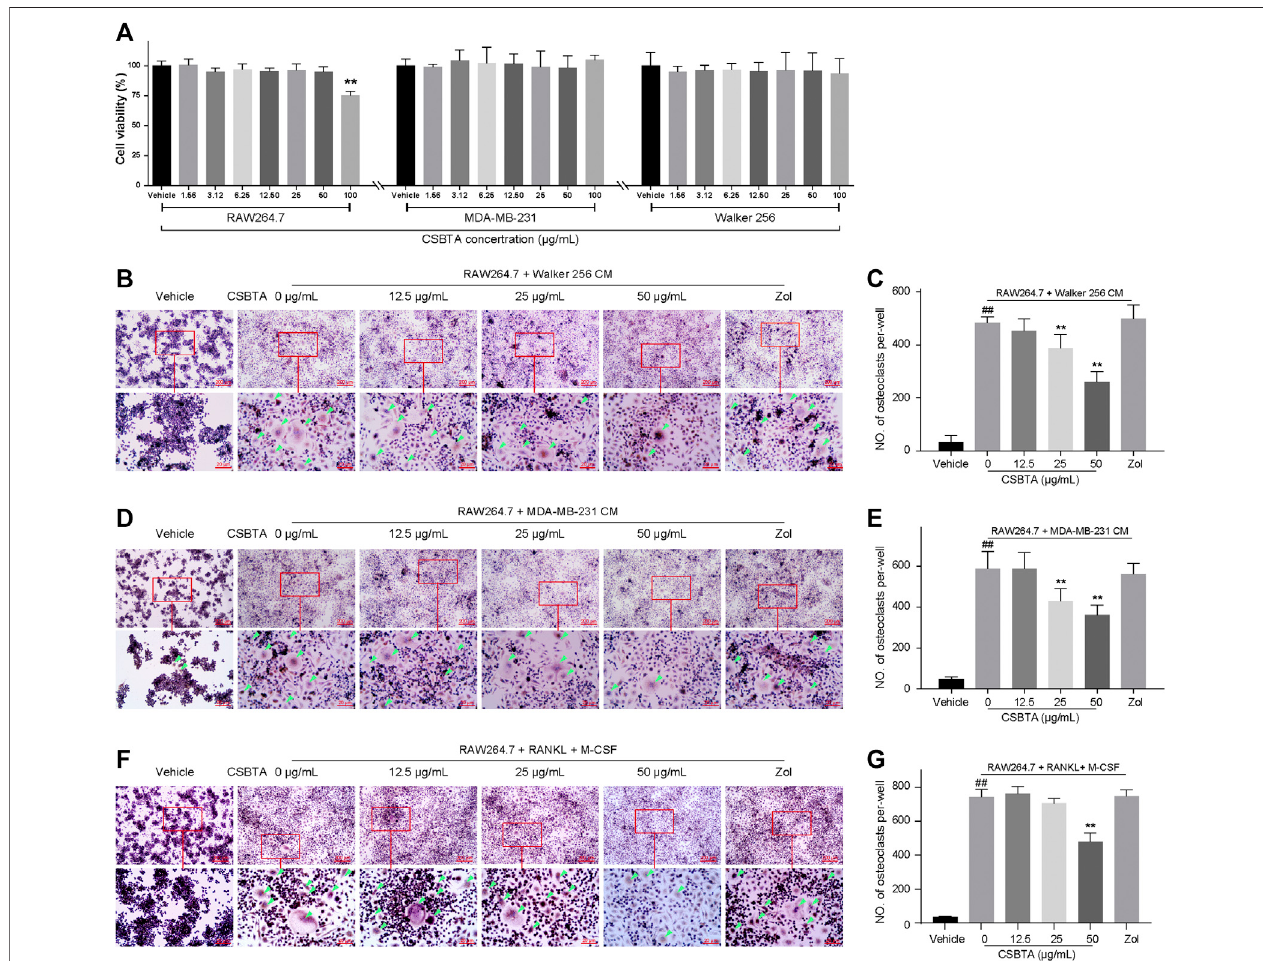
FIGURE 4 | CSBTA inhibited cancer-induced osteoclastogenesis in vitro . (A) Viability of RAW 264.7, MDA-MB-231 and Walker 256 cells after incubation with CSBTAfor 24 h ( n (cid:2) 6). (B) RAW 264.7 cellswere stimulated by Walker 256CM with or without varyingconcentrations ofCSBTA for 4daysfollowed TRAPstaining. (C) The number of TRAP positive cells of the Walker 256 CM induced RAW 264.7 cells per-well. (D) RAW 264.7 cells were stimulated by MDA-MB-231 CM with or without varying concentrations of CSBTA for 5 days followed TRAP staining. (E) The number of TRAP positive cells of the MDA-MB-231 CM induced RAW 264.7 cells per-well. (F) Effect of CSBTA treatment on osteoclast formation in RAW 264.7 (RAW) stimulated by sRANKL (100 ng/ml) and M-CSF (50 ng/ml) for 6 days. (G) The number of TRAP positive cells of the sRANKL (100 ng/ml) and M-CSF (50 ng/ml) induced RAW 264.7 cells per-well. The osteoclasts were marked by green triangles. All experiments were repeated at least three times. Datawas expressed as means ± SD and analyzed by one-way ANOVA. # p < 0.05, ## p < 0.01 vs. the Vehicle group. * p < 0.05, ** p < 0.01 vs. the 0 μ g/ml CSBTA group. Scale bar (cid:2) 200 μ m (low magni fi cation) or 20 μ m (high magni fi cation).